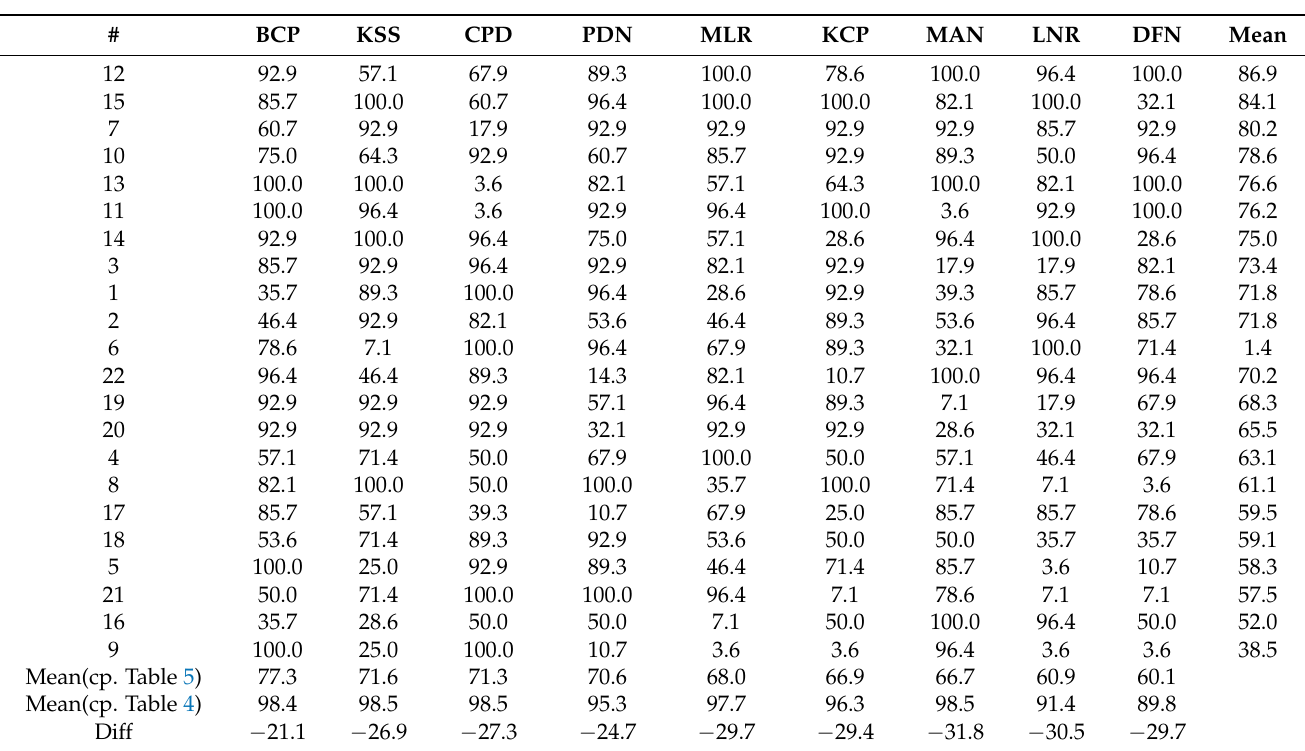
Table 6. PC values of each algorithm for all events within the optimal time